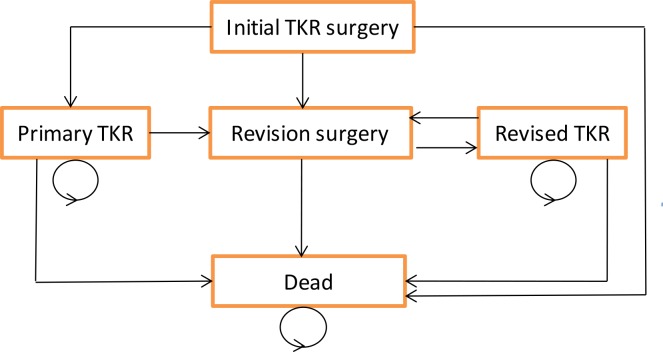
Markov model of TKR